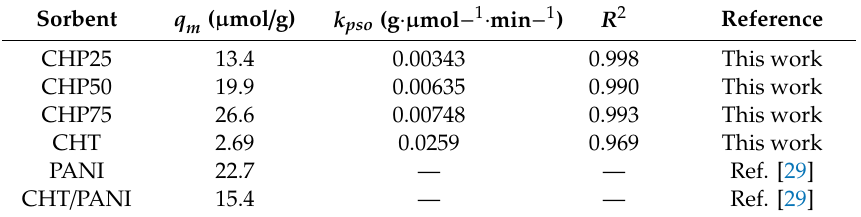
Table 3. Kinetic adsorption parameters of MB with di ff erent sorbents in their powder